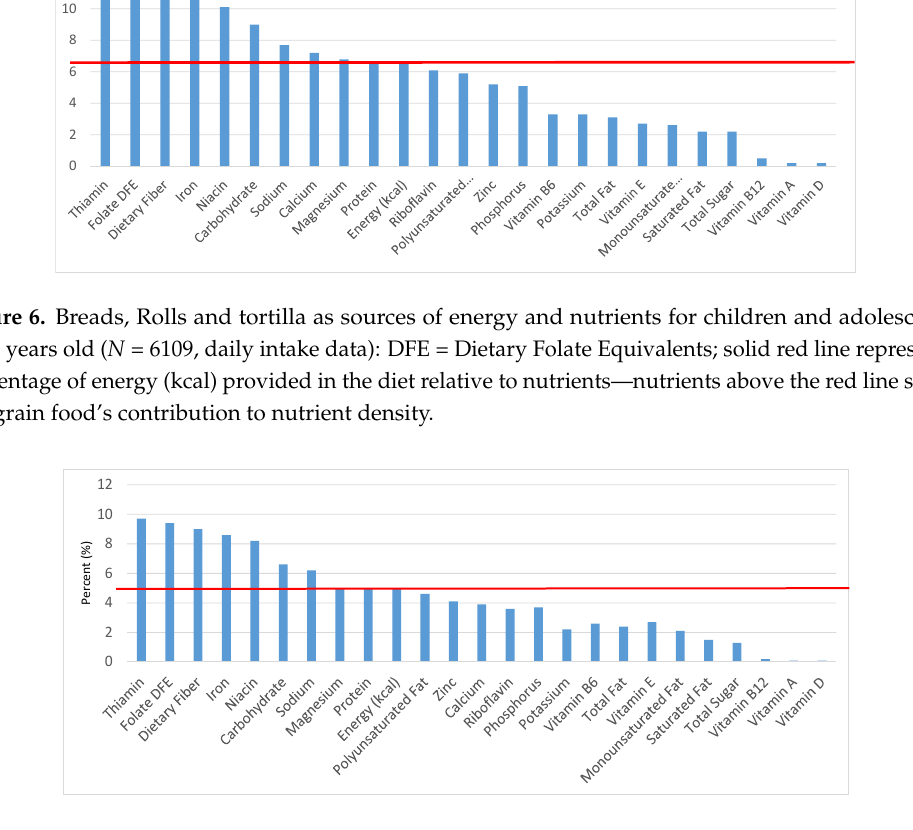
Figure 7. Breads, rolls and tortilla as sources of energy and nutrients for children 1–3 years old ( N = 1423, daily intake data): DFE = Dietary Folate Equivalents; solid red line represents percentage of energy (kcal) provided in the diet relative to nutrients—nutrients above the red line show the grain food’s contribution to nutrient density.